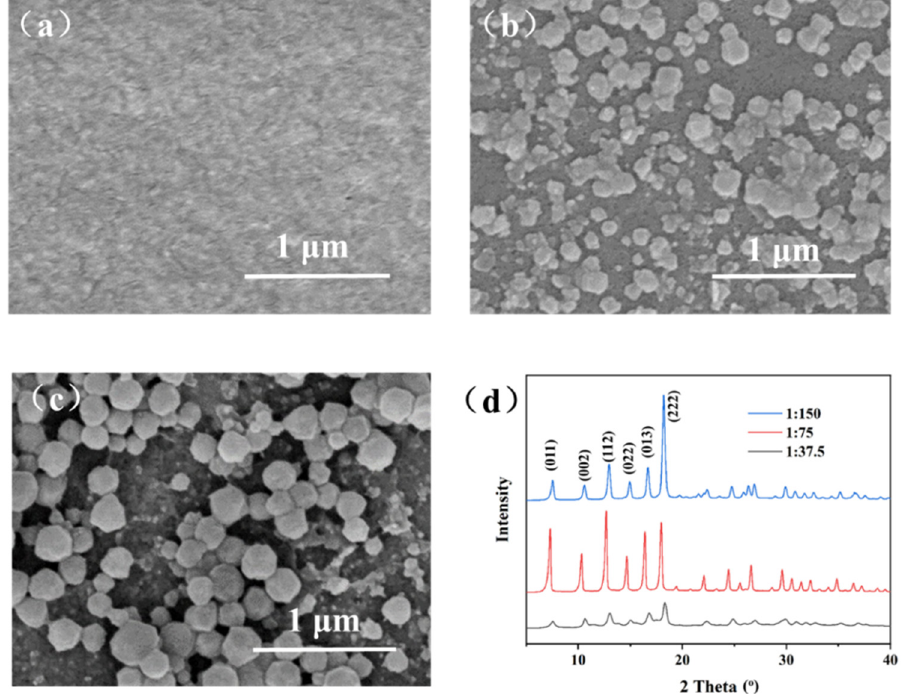
Figure 3. SEM images of ZIF-8 particles on PAN support with different molar ratios of zinc ions to 2-methylimidazole (constant voltage: 1 V, deposition time: 10 min): ( a ) 1:37.5, ( b ) 1:75, ( c ) 1:150; ( d ) XRD patterns of ZIF-8